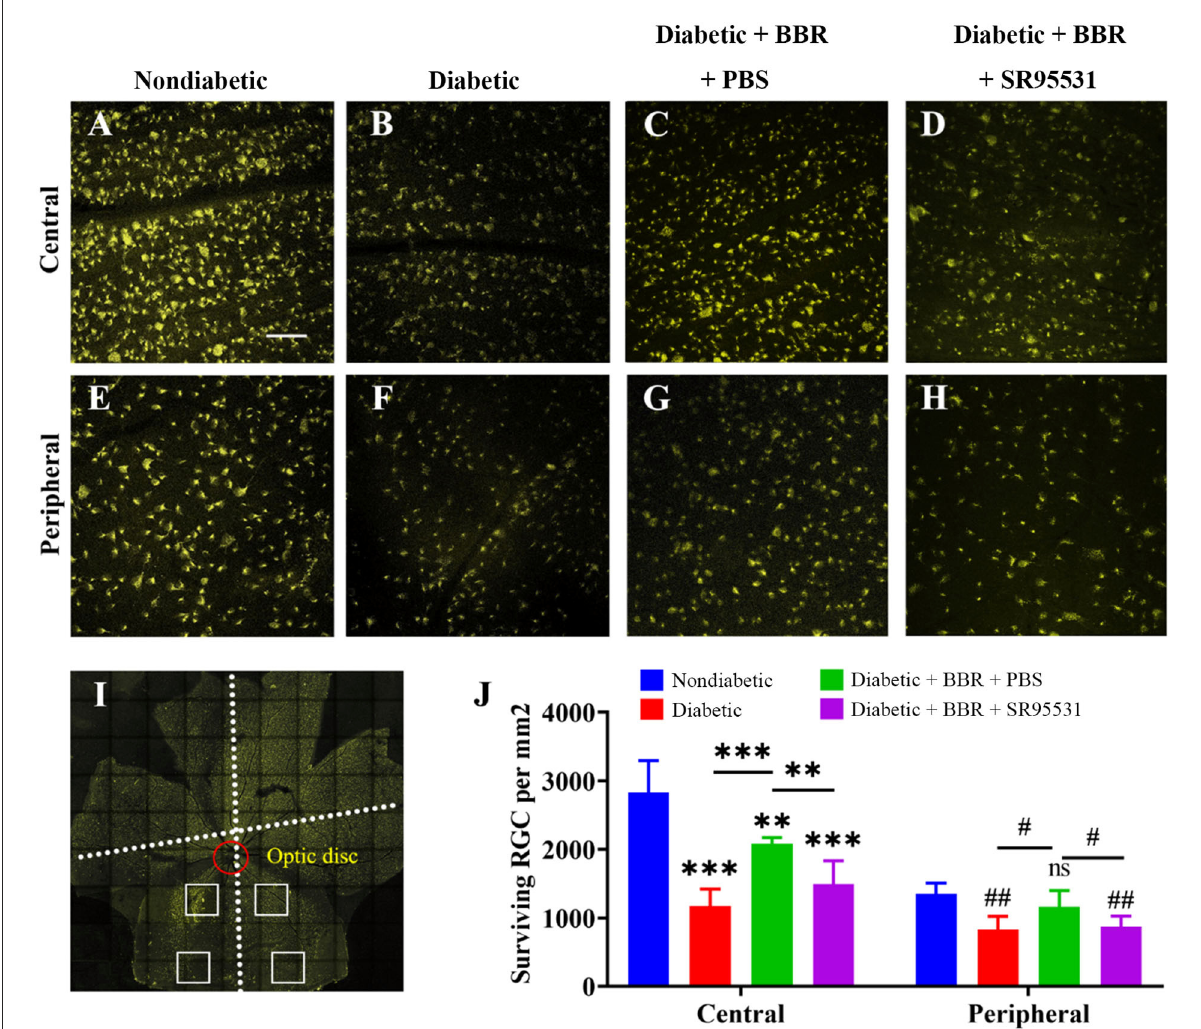
FIGURE5 Low-magnification images of FluoroGold-labeled surviving RGCs in the central and peripheral regions of flat-mounted retinas of rats from all four groups. (A–D) Fluorescence micrographs of the central regions of flat-mounted retinas from rats of the non-diabetic (A) , diabetic (B) , diabetic + BBR + PBS (C) , and the diabetic + BBR + SR95531 (D) groups showing FluoroGold-labeled RGCs. (E–H) Fluorescence micrographs of the peripheral regions of flat-mounted retinas from the non-diabetic (E) , diabetic (F) , diabetic + BBR + PBS (G) , and diabetic + BBR + SR95531 (H) groups showing FluoroGold-labeled RGCs. (I) Flat-mounted retina showing the two eccentric areas of RGC quantification (central and peripheral). Scale bar, 1mm. (J) Quantitative analysis of RGC survival in the four groups, n = 5 (ns, no significant difference; # P < 0.05; ** and ## P < 0.01; *** P < 0.001; one-way ANOVA; the results are expressed as the mean ± SE. BBR, berberine; RGCs, retinal ganglion cells; scale bar, 50 µ m). For specific data, see Supplementary Table